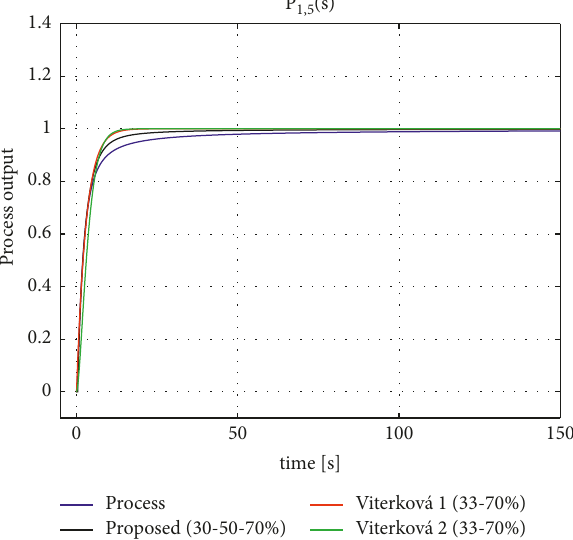
Figure 14: Process reaction curve and step responses for FFOPDT model method # 6 and FOPDT and DPPDT model methods # 8 and # 10,